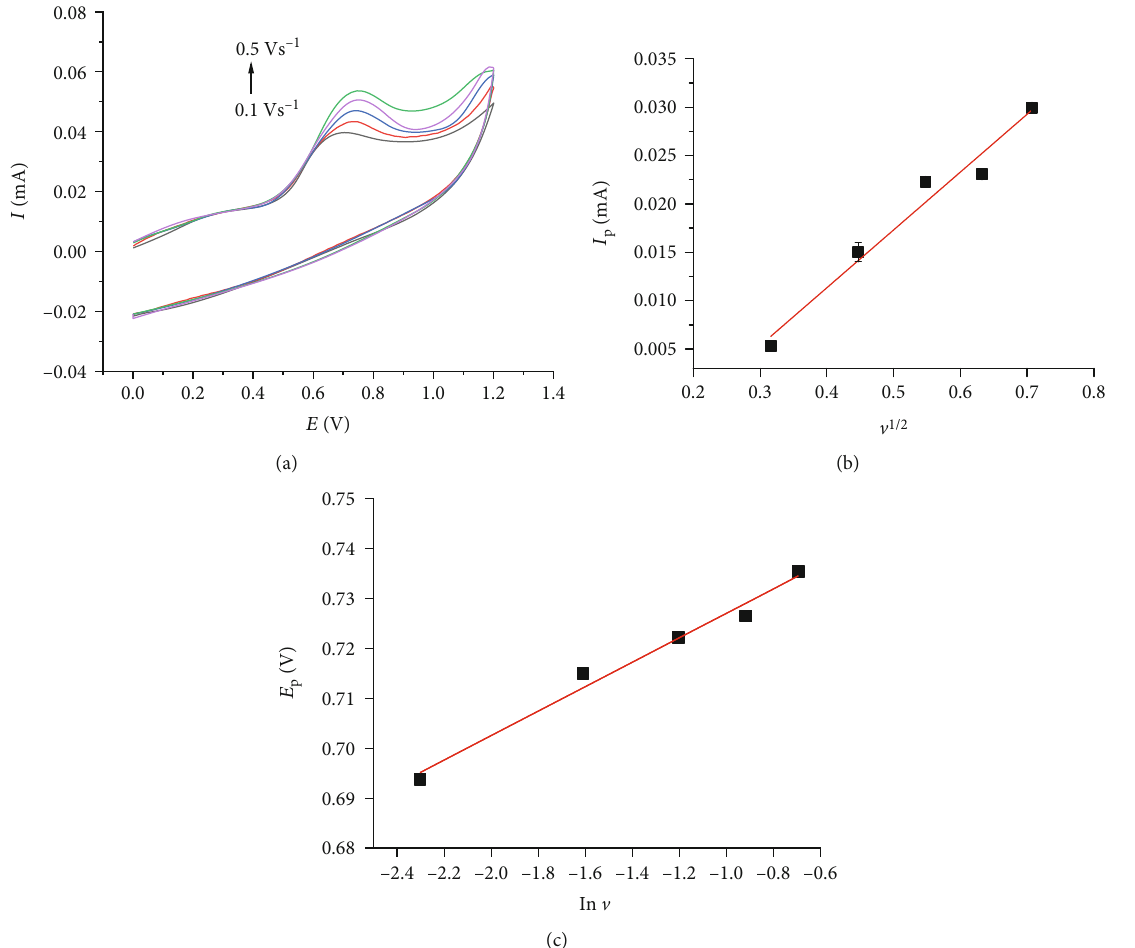
Figure 10: CVs of 5mM DCF at various scan rates in 0.2M BRS pH6.5 on ZIF-67/ g -C